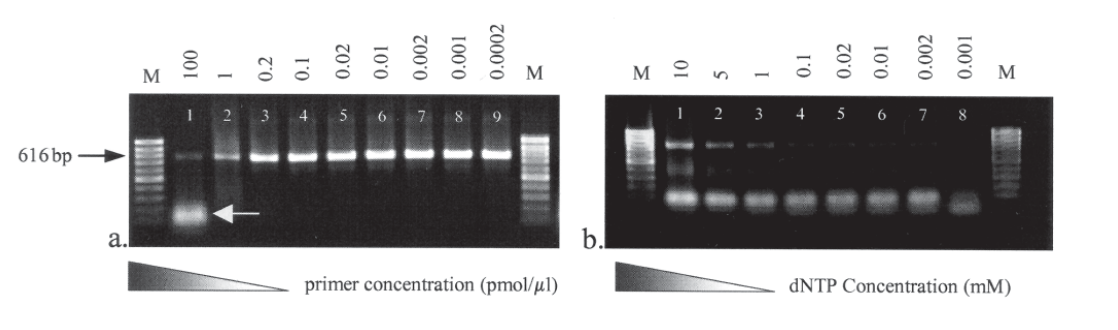
Fig. 2. Electrophoretic analysis of RT-PCR products deriving from different primer (a) and dNTP concentrations (b). M, molecular size